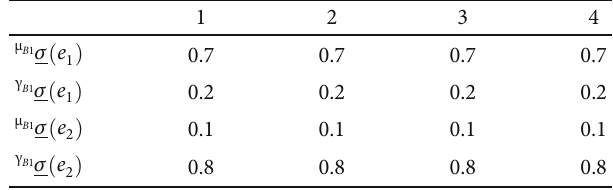
Table 23: Lower approximation of B